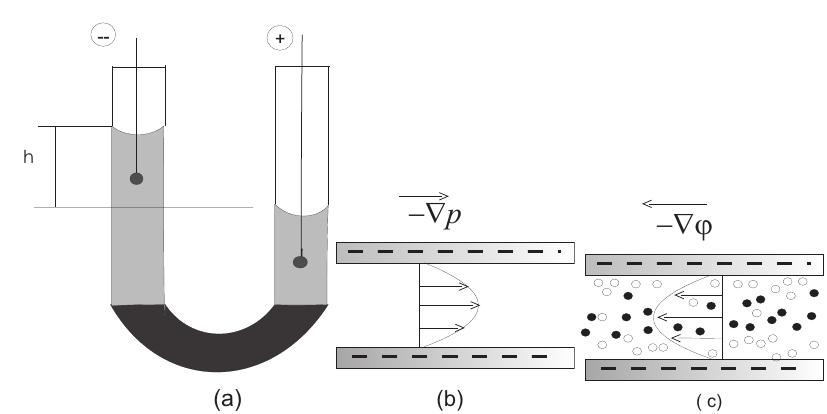
Figure 1. ( a ) F.F. Reuss experiment (1808) with water in the U-tube plugged with sandstone sample: applied electric field results in water level change of the hight h (effect of electroosmos). ( b ) Pressure driven flow in a pore space. ( c ) Due to the double electric layer (DEL) theory, there is an excess of ions of the same signe in the bulk pore fluid. As a result, a flow occurs if an electric field is applied.